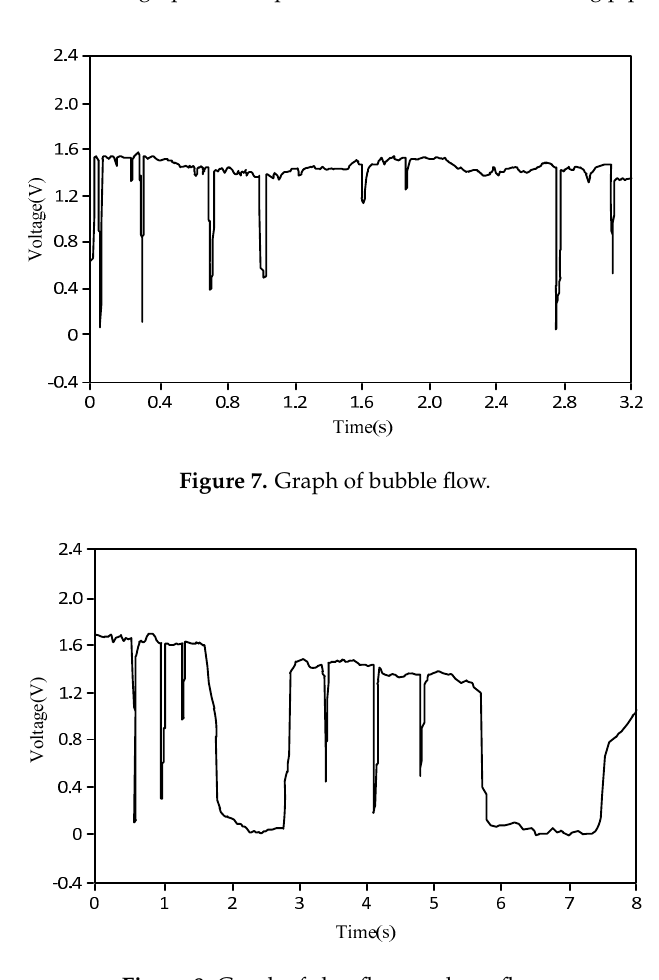
Figure 8. Graph of slug flow or churn flow.